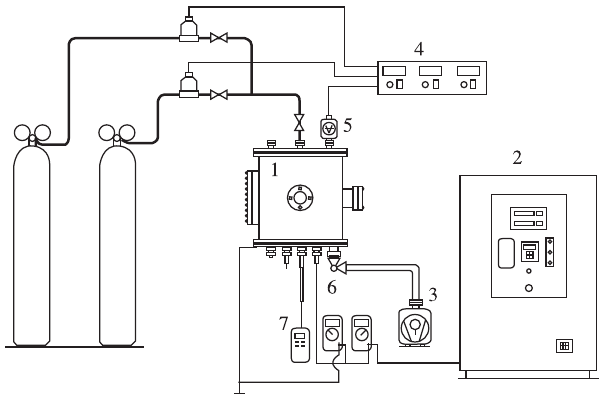
Figure 2. Schematic representation of the experimental system used in both sintering cycles: samples on the cathode and samples on the anode.